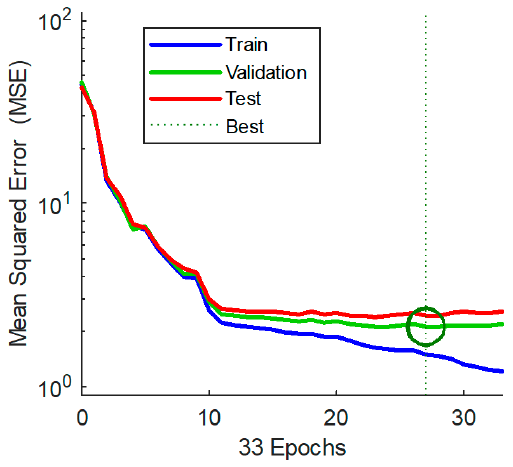
Figure 8. ANN—best training performance. Figure 8. ANN – best training performance.